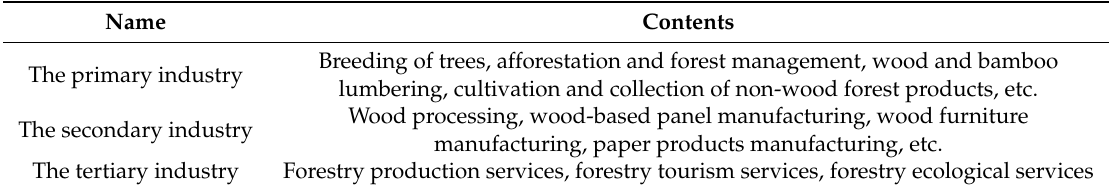
Table 1. The industry classification of state-owned forestry enterprises in Northeast